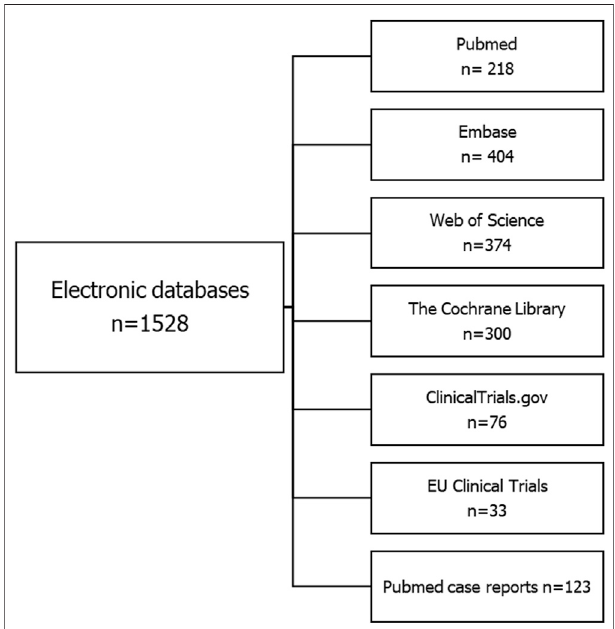
FIGURE 1 | Results of electronic search (up to 28 th April